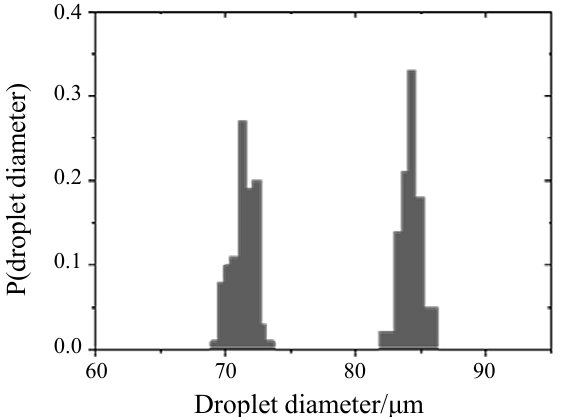
Figure 3. Droplet diameter distribution of the un-dyed w/o/w double emulsion, revealing the monodispersity of the sample both for the inner water and the outer oil